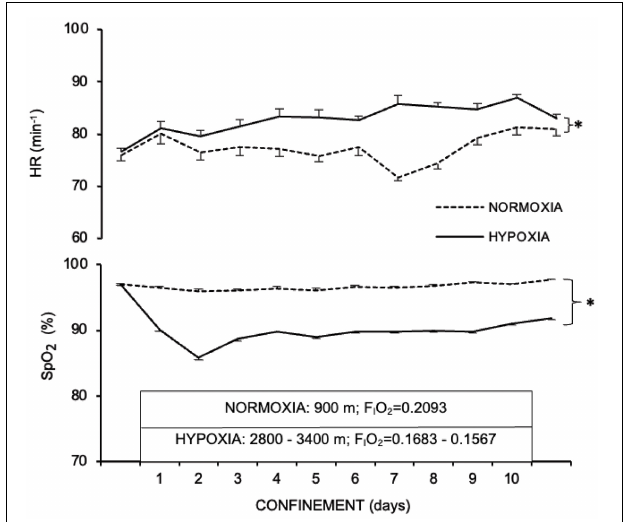
FIGURE 1 | Nocturnal heart rate (HR, min - 1 ) and capillary oxyhaemoglobin saturation (SpO 2 , %) before (PRE), during, and at the end (POST) of the NORMOXIA and HYPOXIA trials. Values are mean ± SEM, n = 8. ∗ Significant differences between NORMOXIC and HYPOXIC confinement; p <